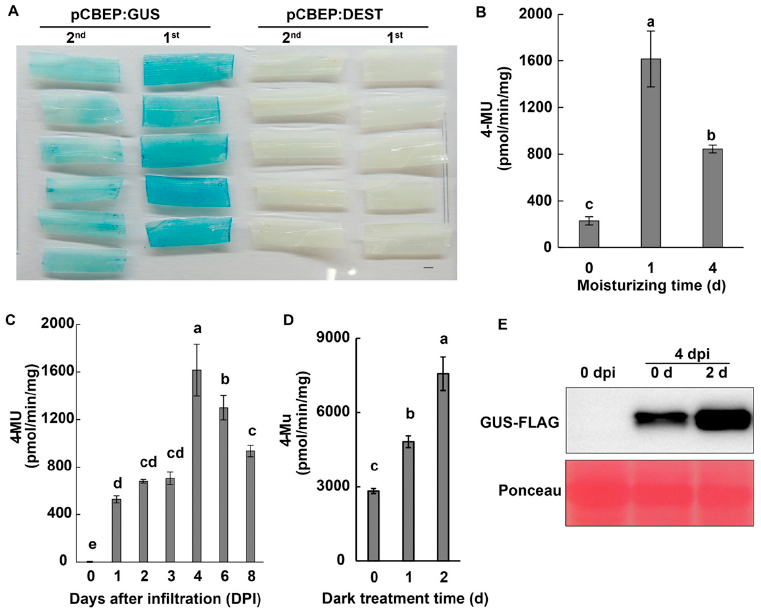
Figure 2. Optimizing conditions for transient expression in barley (var. E9) leaves. ( A ). GUS staining in the first (1st) and the second (2nd) leaves following the infiltration of AGL1 (pCBEP:GUS) at 4 dpi. Empty vector (pCBEP:DEST) used as a negative control. Scale bars = 1.5 mm. ( B ). Quantifying GUS activity under different moisturizing times (0, 1 or 4 d) following the agro-infiltration in the first leaf of barley at 4 dpi. ( C ). Quantifying GUS activity at different cultivation times (0–8 dpi) with 1 d moisturizing after agro-infiltration. ( D ). Quantifying GUS activity under 1 or 2 days of dark treatment before collecting samples at 4 dpi. ( E ). Western blot analysis of FLAG-tagged GUS protein accumulation under dark treatments at 0 dpi (the first line) and 4 dpi (last two lines) with 0 d or 2 d dark treatment. Signals were detected with an anti-FLAG antibody, quantitated, and normalized to the Ponceau loading control. The experiments were syringe-infiltrated with 0.5 OD 600 of AGL1 (pCBEP:GUS). Data shown are mean ± SD ( n = 6). Different letters indicate significant differences at p < 0.01. Three biological replicates were performed.